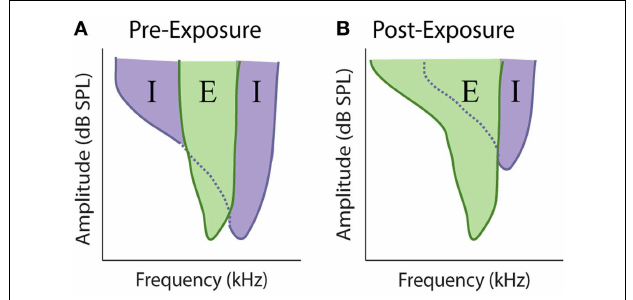
FIGURE 7 | Model of excitatory and inhibitory receptive field overlap in the auditory system . (A) Under control conditions there is strong inhibition (purple) at edge of the characteristic excitatory (green) frequency. At frequencies where the threshold for inhibition is equal to or lower the threshold for excitation, the response of the neuron is inhibited, resulting in narrow excitatory tuning curves. (B) Noise-exposure that causes restricted cochlear damage above the excitatory characteristic frequency results in the loss of this side-band inhibition, resulting in broader excitatory tuning